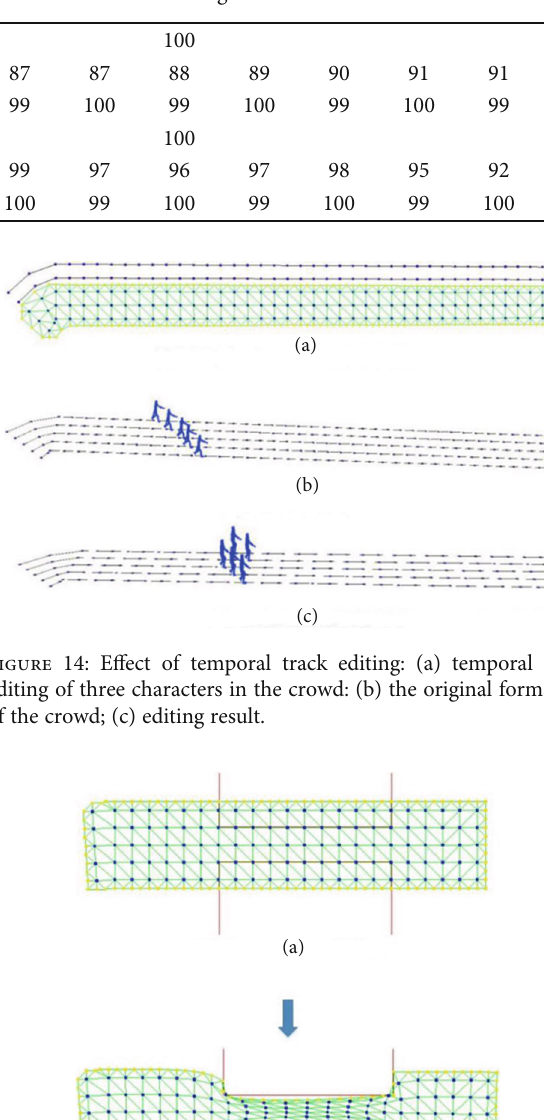
Table 2: Crowd speed comparison before and after editing.